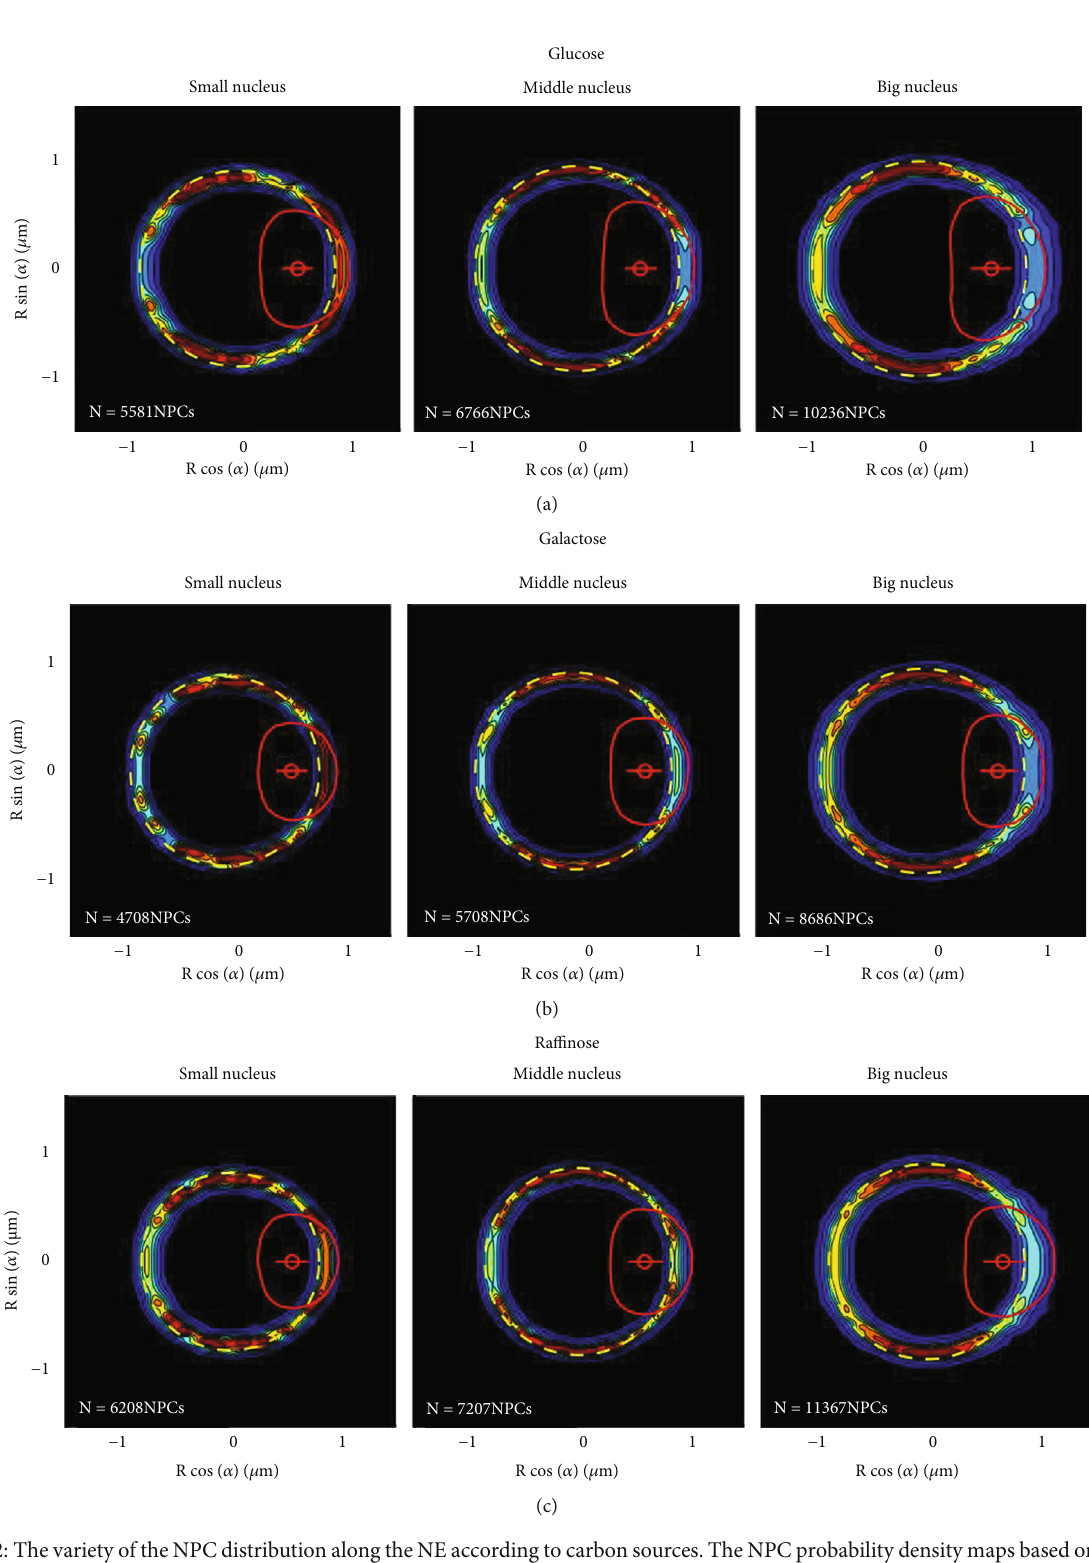
Figure 2: The variety of the NPC distribution along the NE according to carbon sources. The NPC probability density maps based on analysis of asynchronous cells cultured with glucose (a), galactose (b), and ra ffi nose (c). The small-sized nuclei are composed of the newborn nuclei and the mother nuclei in the G1 phase; the middle-sized nuclei consist of the nucleus in the later G1 phase and S phase. The nuclei in the later S phase and early G2 phase constitute the bigger-sized nuclei. The dashed yellow circle represents the nuclear envelope determined according to the “ NucQuant ” technology; the red curve represents the median nucleolus contour; the red small circle represents the median nucleolar centroid; N represents the number of the NPC clusters used to generate the cumulative percentage